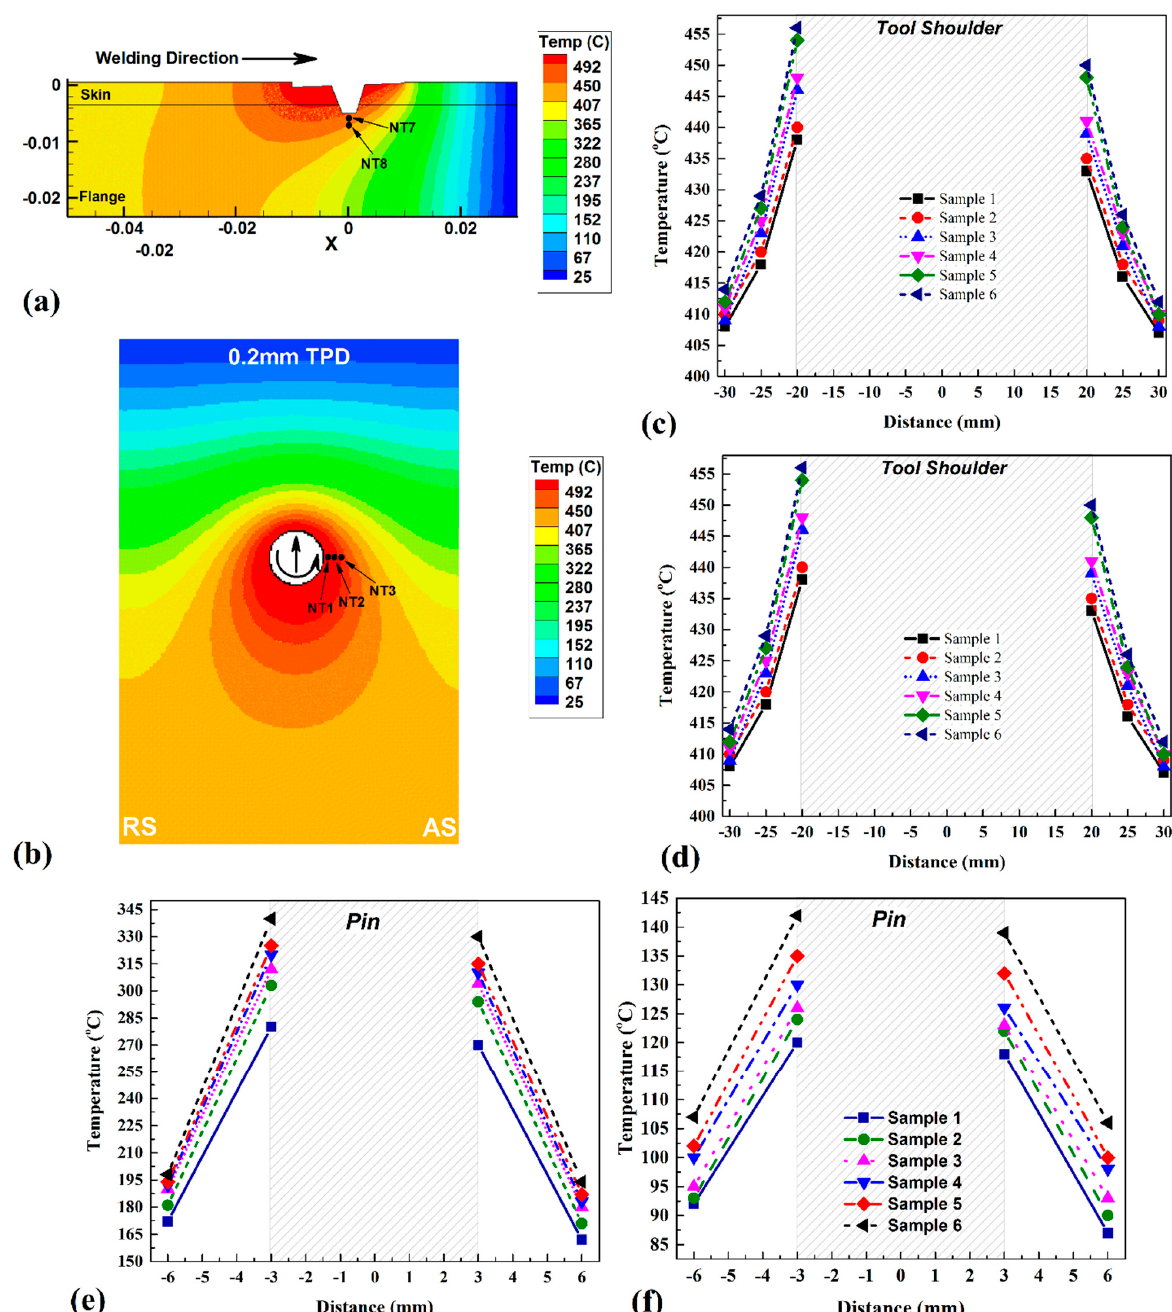
Figure 4. ( a ) Simulation results of internal heat flow at 0.2 mm TPD. ( b ) Simulation results of internal heat flow at 0.2 mm TPD. ( c ) Experimental and ( d ) maximum simulated temperature and heat diffusion on skin. ( e ) Recorded and ( f ) simulated results of maximum temperature and heat diffusion on flange.